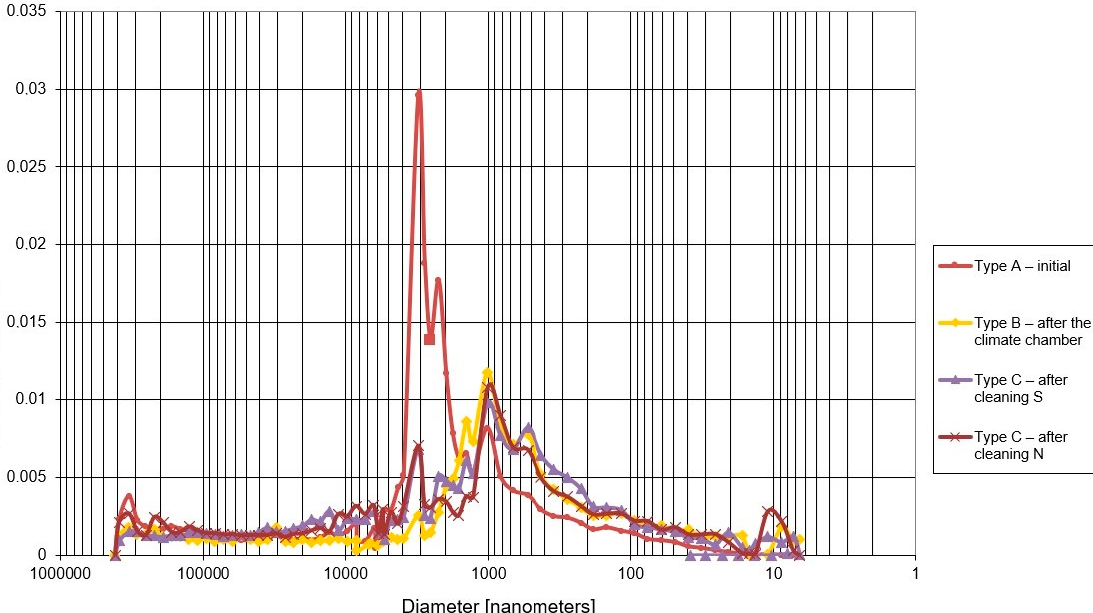
( b ) Figure 9. Integral curves of pore distribution for mineral-based plaster: ( a ) full measuring range; ( b ) pore range related to freeze–thaw durability (from 100 nm to 1000 nm). Table 2. Porosity test results. Sample Type